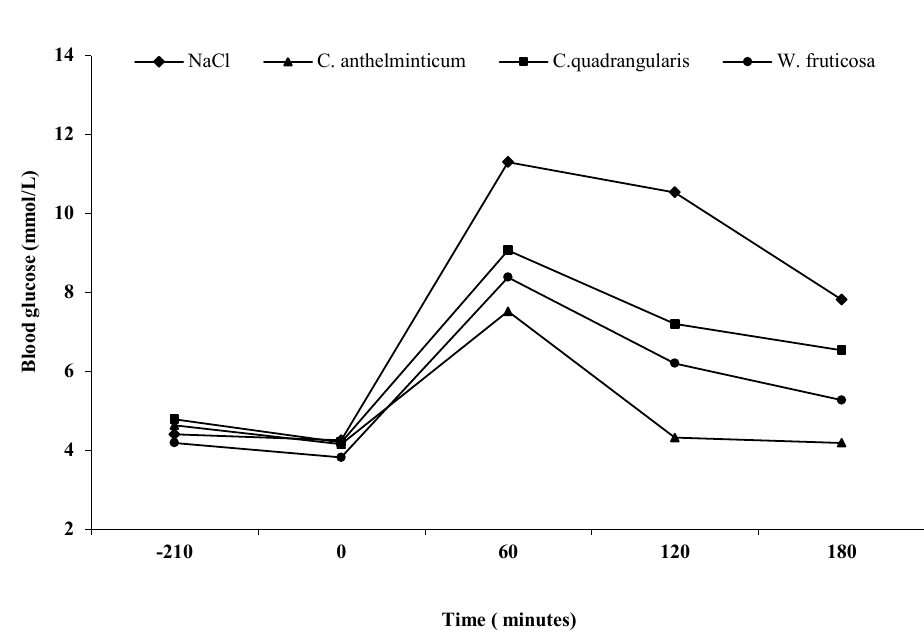
Figure 2 . Oral glucose tolerance test on C. anthelminticum , Cissus quadrangularis , and Woodfordia fruticosa Kurz extracts in normal fasted rats with glucose-induced hyperglycemia. Data are mean ± SE. n = 6 for each group. ( P <0.001) for the three extracts when compared with normal control ( P <0.01)